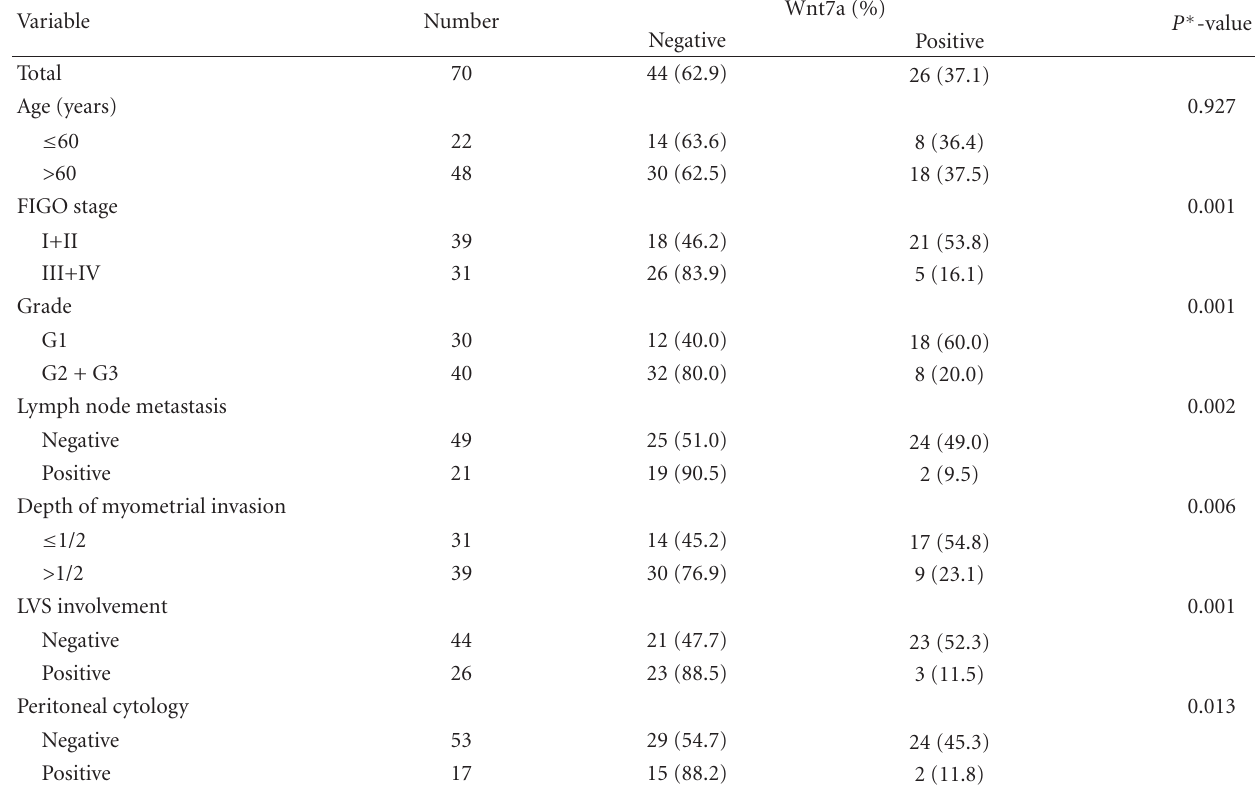
FIGO: International Federation of Gynecology and Obstertics; LVS: lymph vascular space and ∗ Chi-square test.